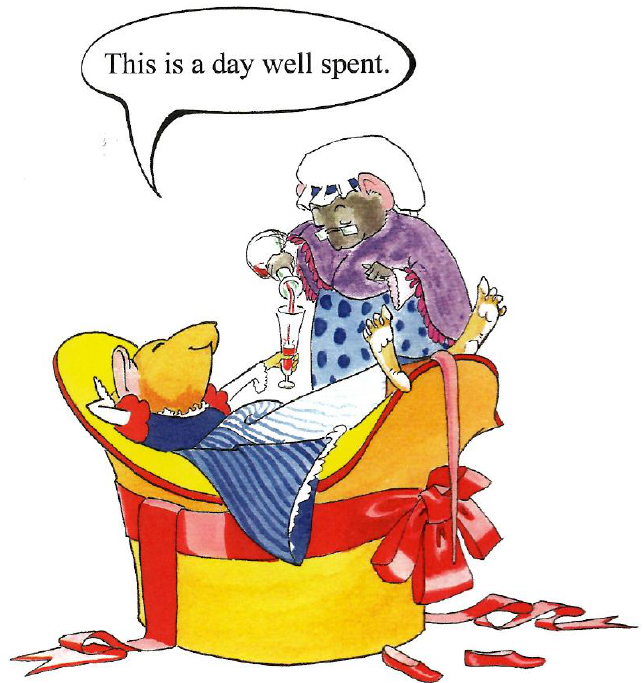
Figure 12. McMaster’s illustration for The Beautifull Cassandra (Austen 2021), p.